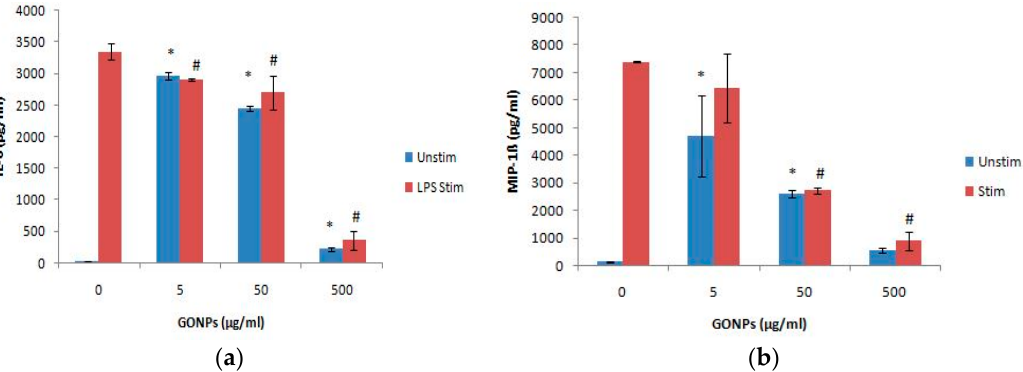
Figure 5. The inflammatory biomarker expression levels of whole blood cell cultures exposed to GO. NPs in the absence or presence of LPS: ( a ) IL-6 expression levels and ( b ) MIP-1 β expression levels. Data represents mean ± SD with n = 4. Bars marked with symbols indicate significant differences ( p < 0.01). Significance demarcated by: *—significantly different compared to negative control ( p < 0.001), # -significantly different compared to positive control ( p < 0.001).